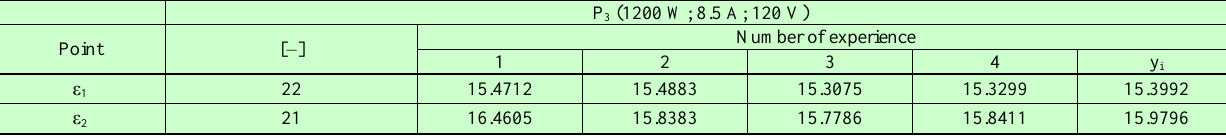
Table 4. Value of statistic F obl and (ΔF = F obl – F kr ) for a reduced compression ratio and its effect on h śr Points according to the regulator characteristics